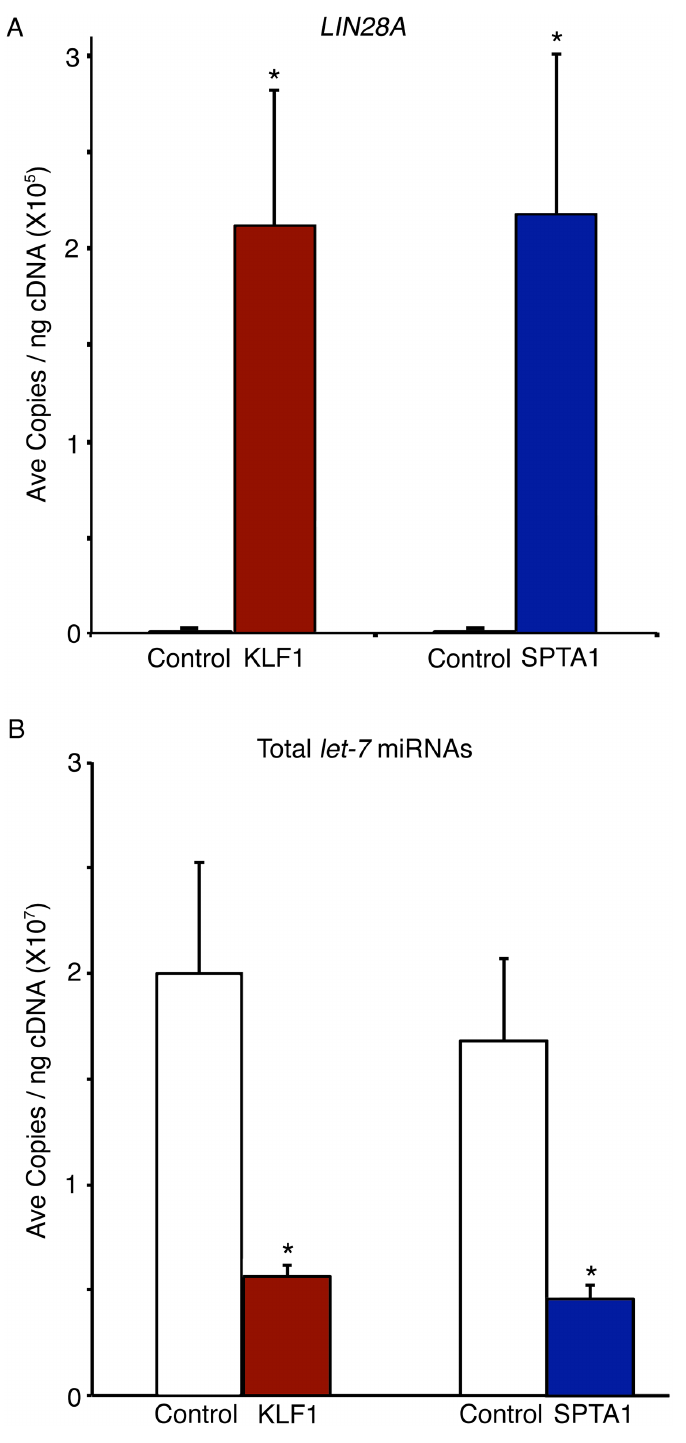
Fig 2. LIN28A over-expression mediated by KLF1 or SPTA1 promoter regulates the let-7 family of miRNAs. RNA samples from erythroblasts cultured on day 14 were examined for (A) LIN28A over- expression and (B) the total levels of let-7 miRNAs using Q-RT-PCR. Mean value ± SD from three separate donors for each condition: KLF1-Empty vector control (control, open bar), KLF1-LIN28A-OE (KLF1, red bar), SPTA1-Empty vector control (control, open bar), and SPTA1-LIN28A-OE (SPTA1, blue bar). Asterisks indicate p < 0.05.